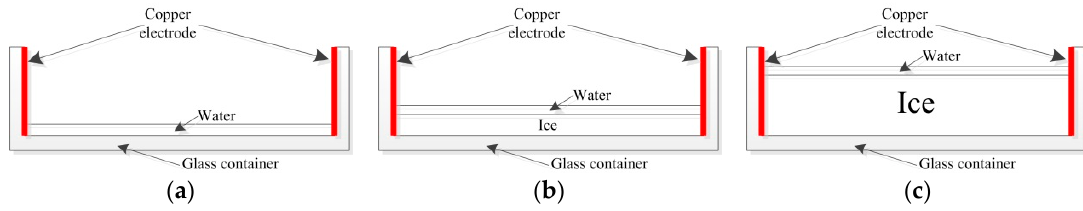
Figure 3. Schematic image of the formation process of ice layer: ( a ) Initial stage; ( b ) Interim period; and ( c ) Later period.